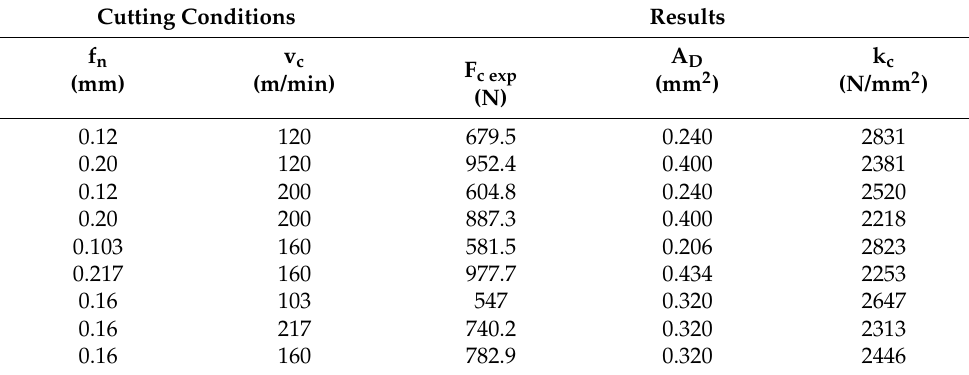
Table 6. Calculated specific cutting force